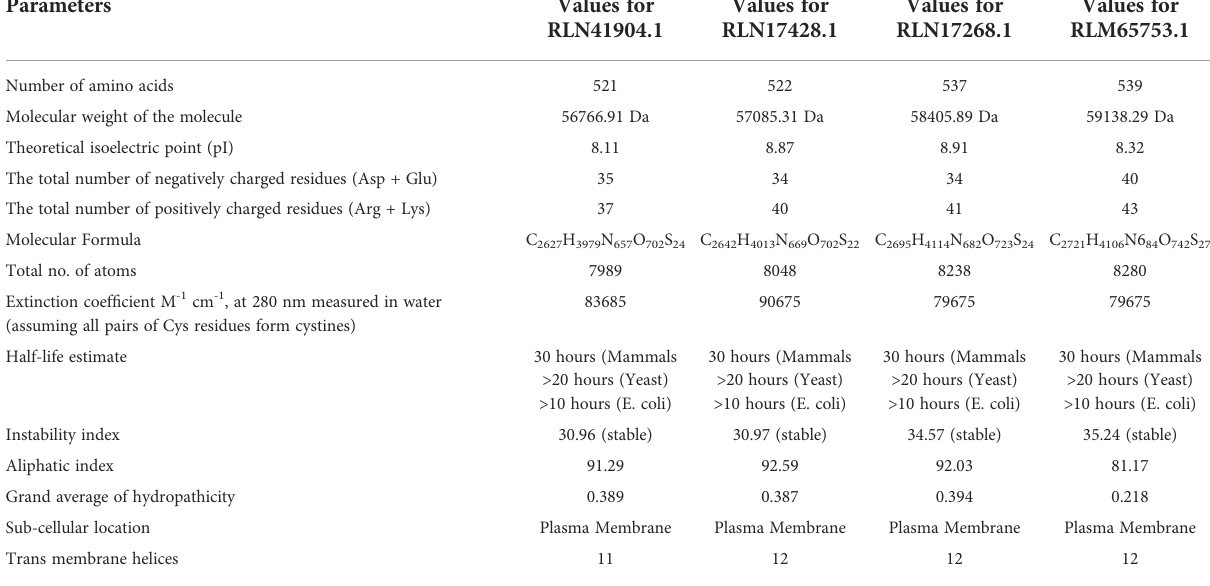
TABLE 3 Predicted physiochemical properties of selenite transporters.